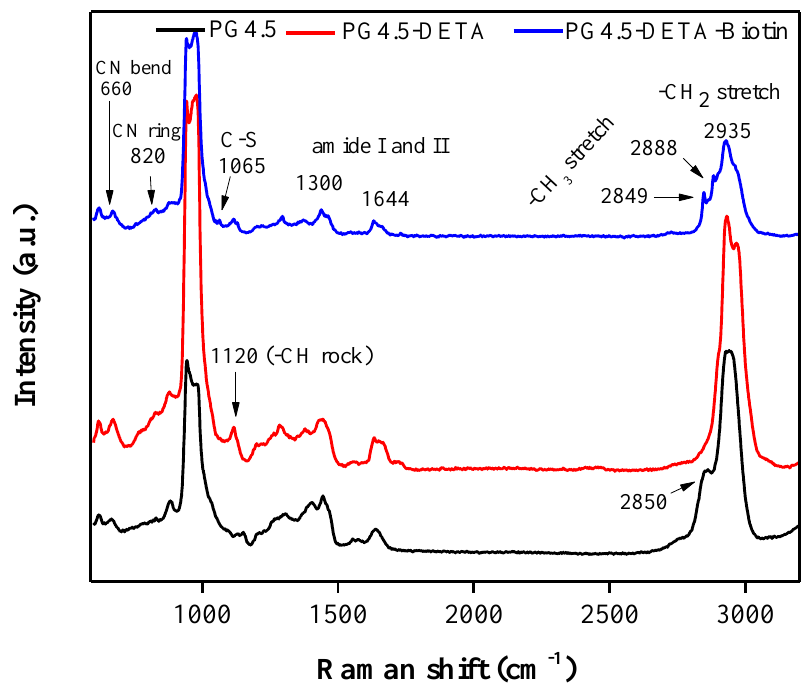
Figure 2. ( A ) FTIR spectra of PG4.5, PG4.5-DETA, and PG4.5-DETA-biotin. ( B ) Raman spectra of PG4.5, PG4.5-DETA, and PG4.5-DETA-biotin.